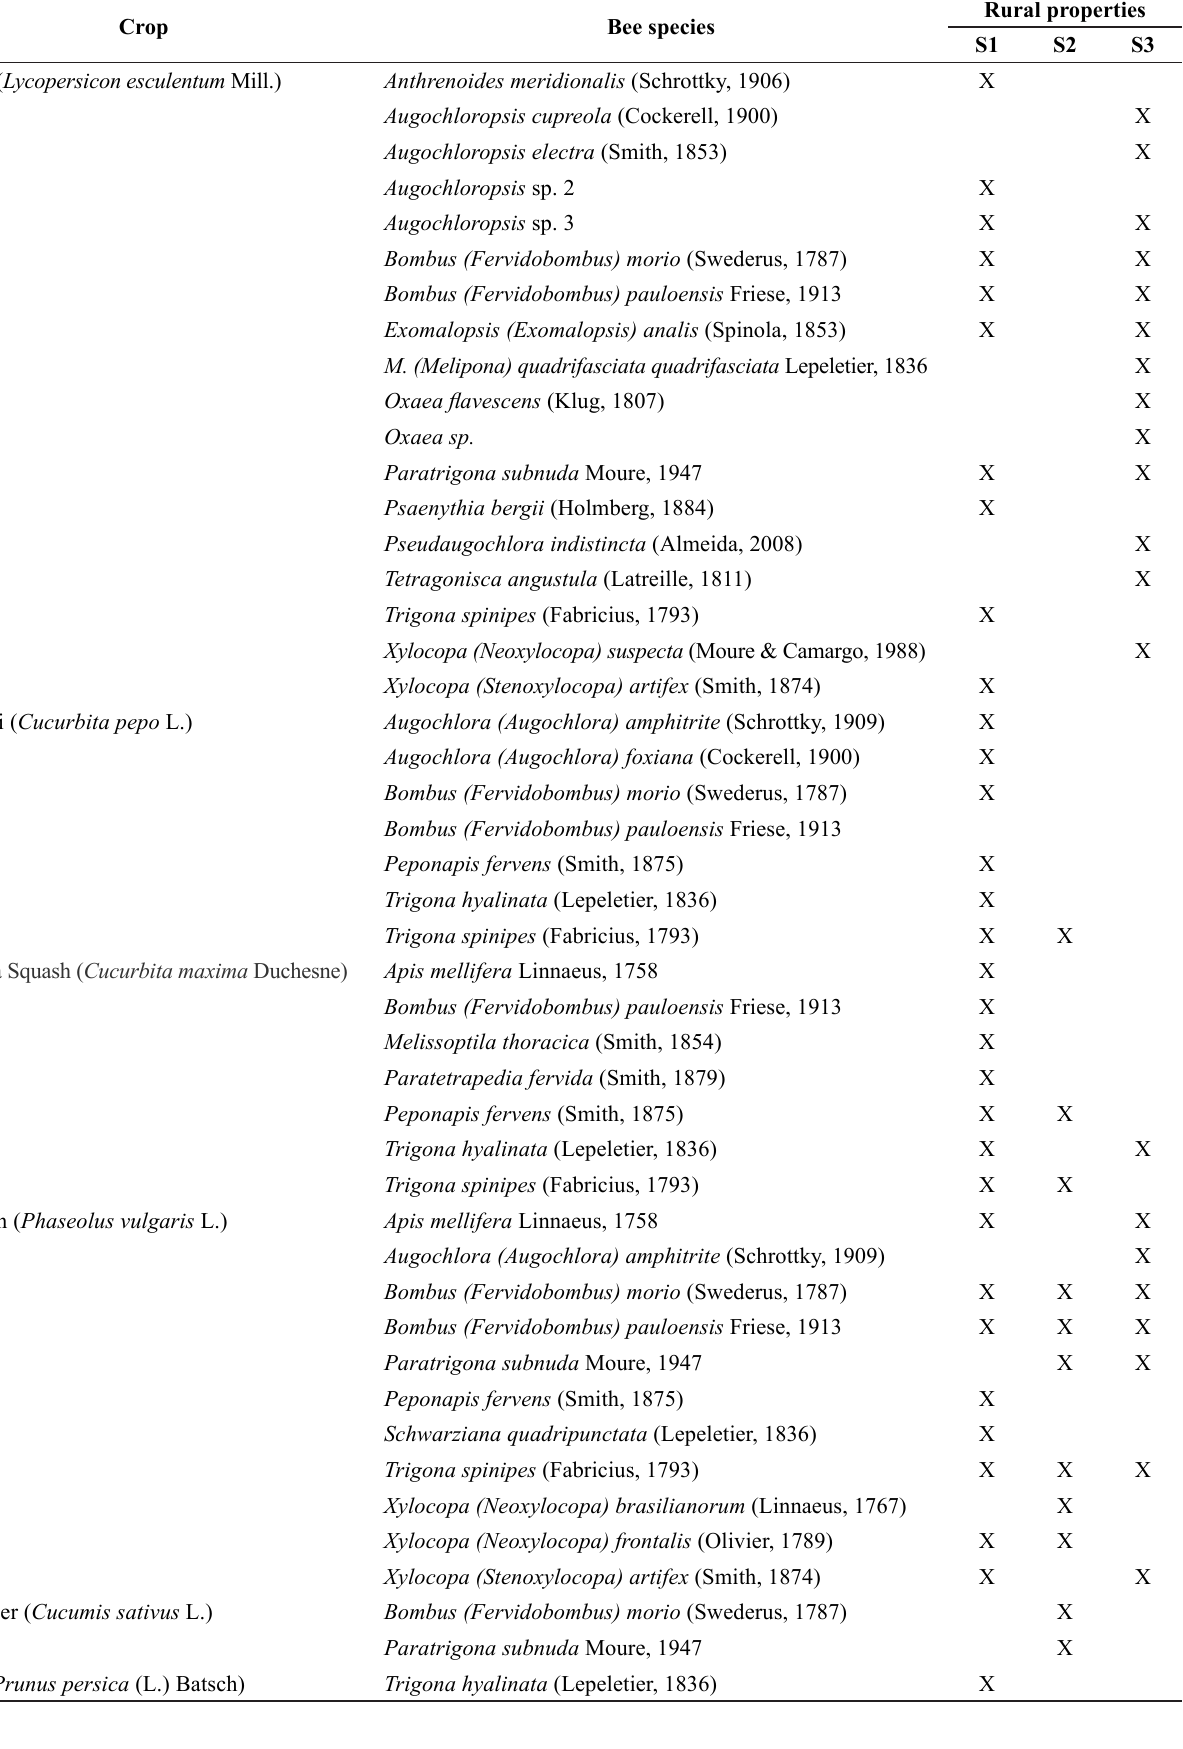
Table 1 . Bee species sampled on crop flowers at three smallholder rural properties in Guapiara, São Paulo state, Brazil, between May 2012 and March